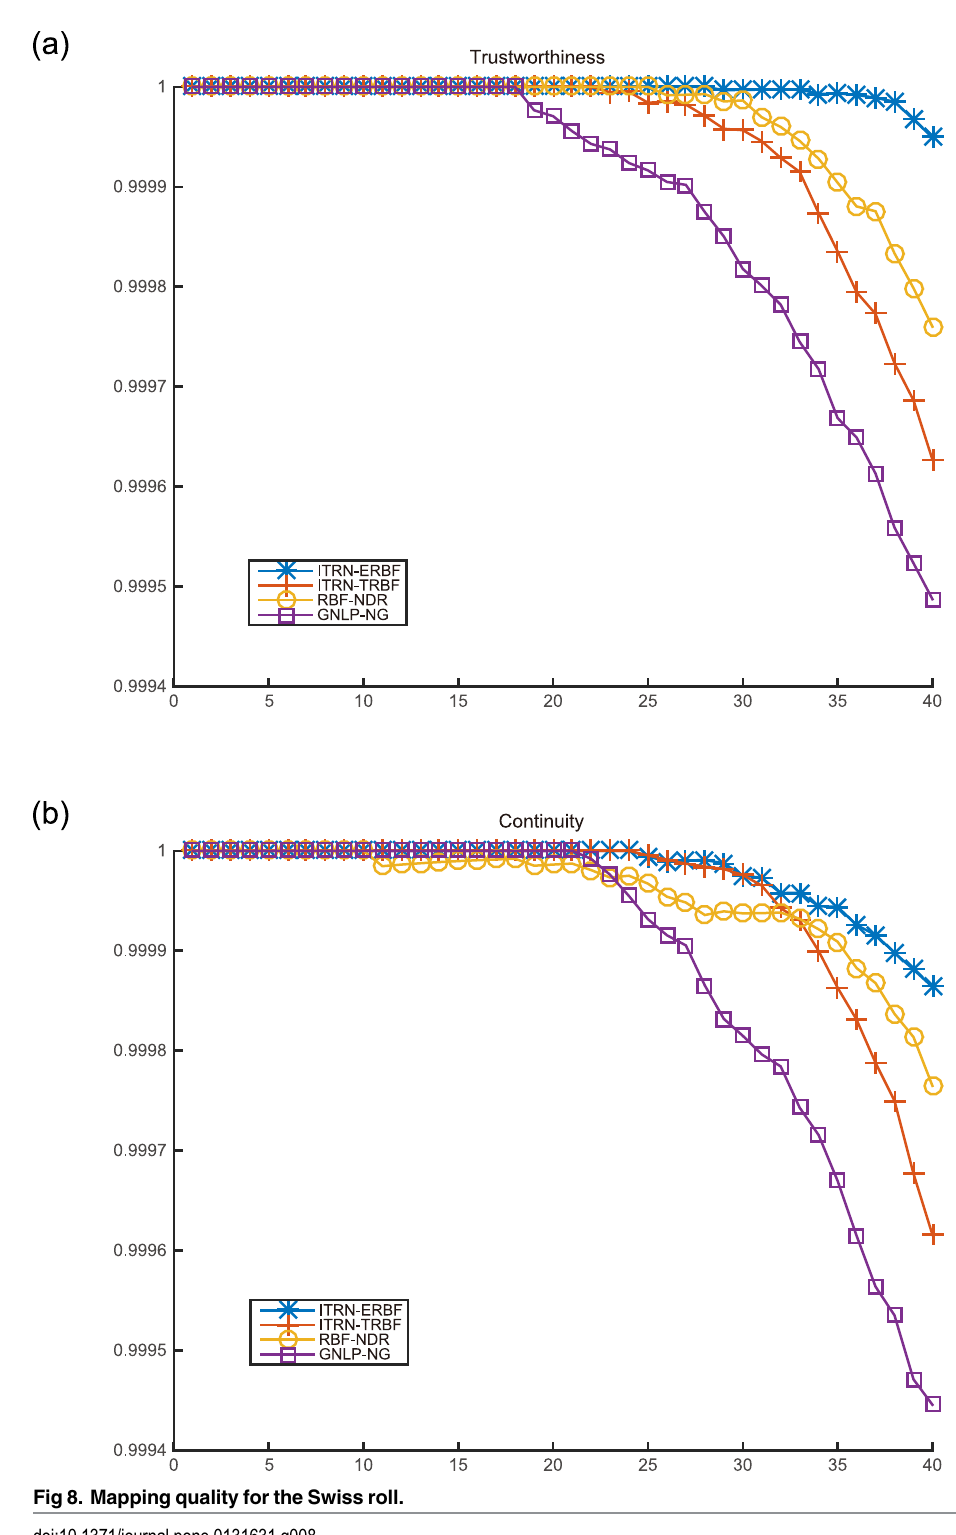
Fig 8. Mapping quality for the Swiss roll.